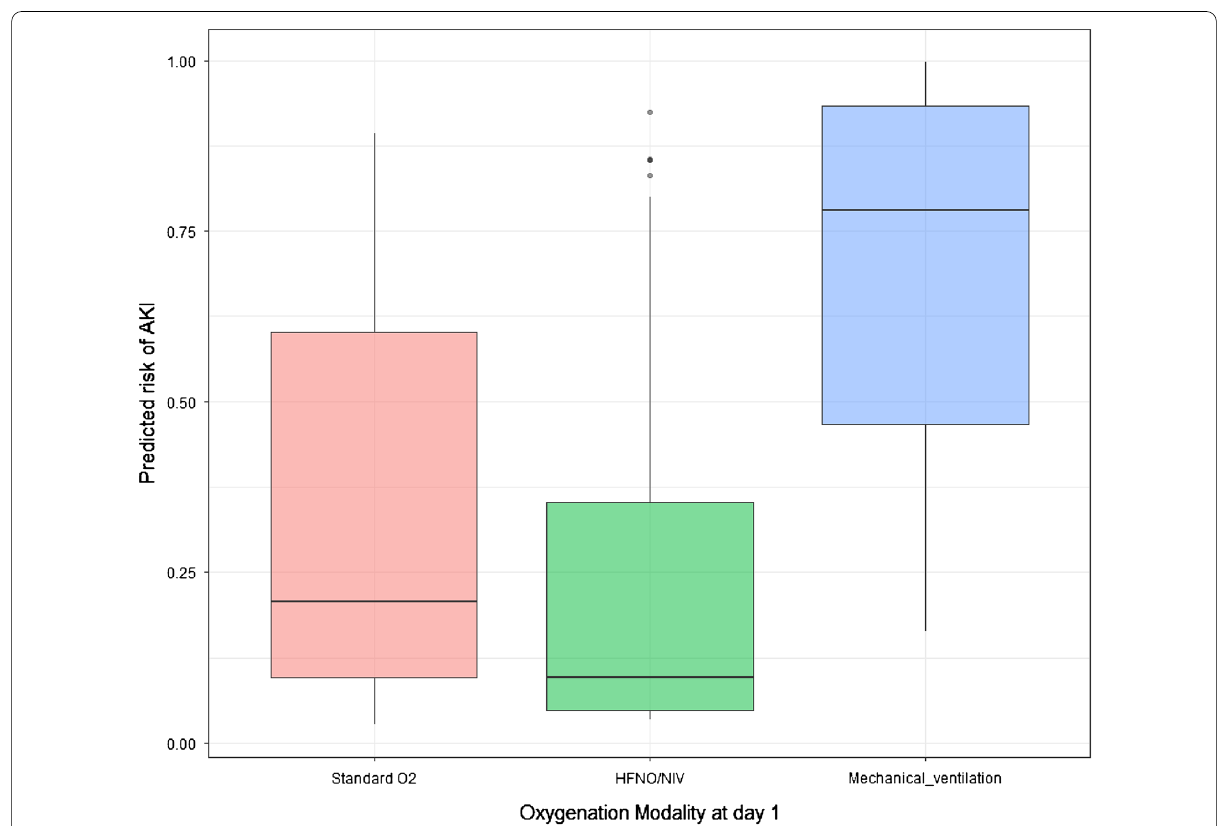
Fig. 1 Predicted probability of acute kidney injury obtained using a multivariable model according to oxygen delivery